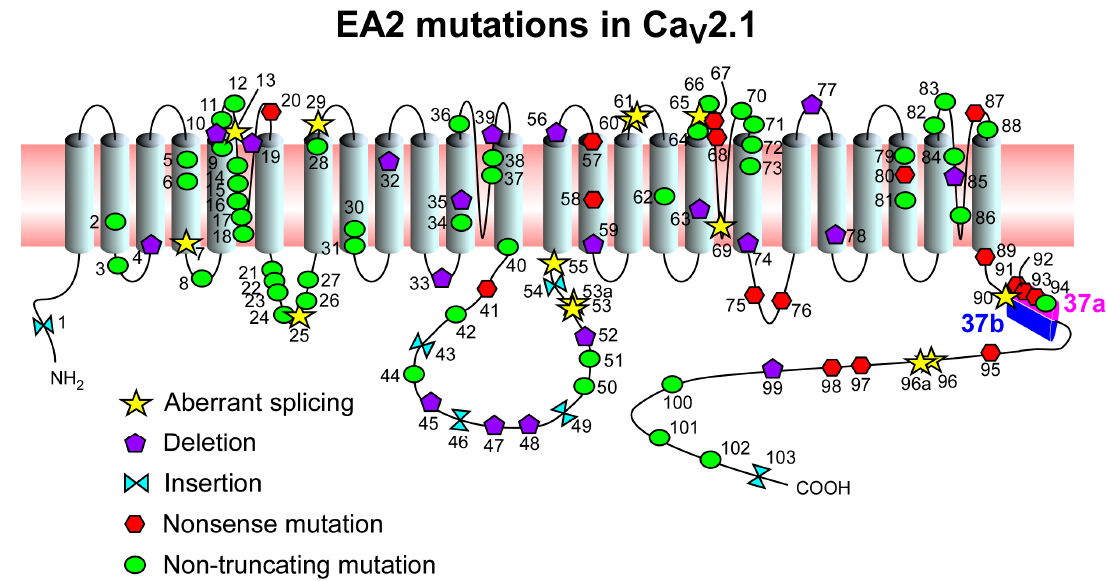
Figure 1. Scheme of human Ca V 2.1 highlighting the position of 103 mutations causing EA2. Topology of Ca V 2.1 as for Uniprot entry O00555. The two mutually exclusive exons 37a and 37b are shown in pink and blue, respectively. The 103 mutations are depicted in the scheme and listed in Table